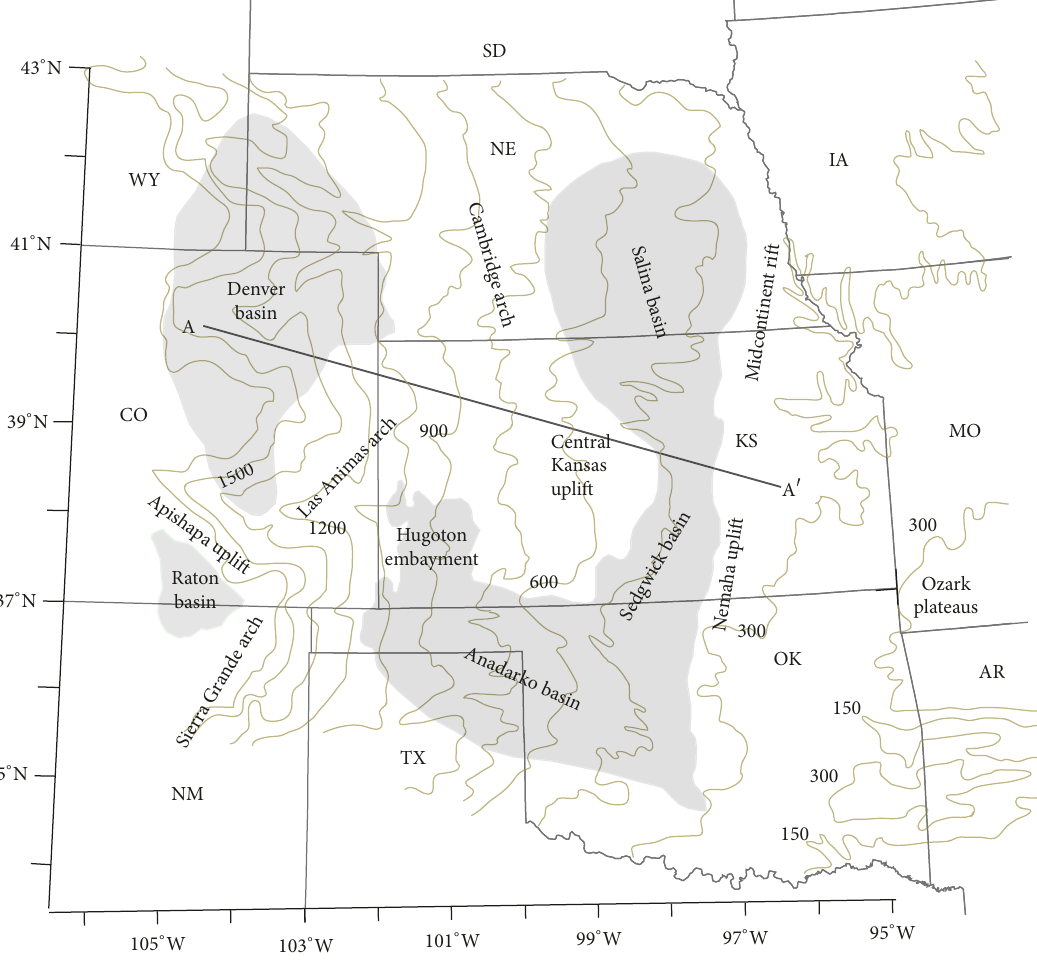
Figure 2: Physiographic map of study area, in the Great Plains, from Nelson et al. ([7], Figure 1 ). The figure shows land surface elevation contours (m), state lines, location of structural features, sedimentary basins (shaded), and the 800 km cross-section line A-A 󸀠